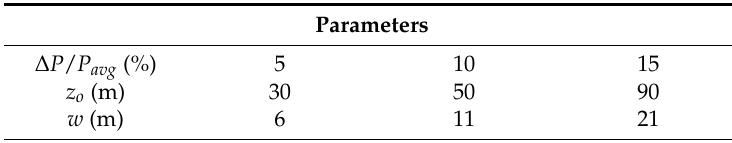
Table 2. Parametric study: parameters and notations.